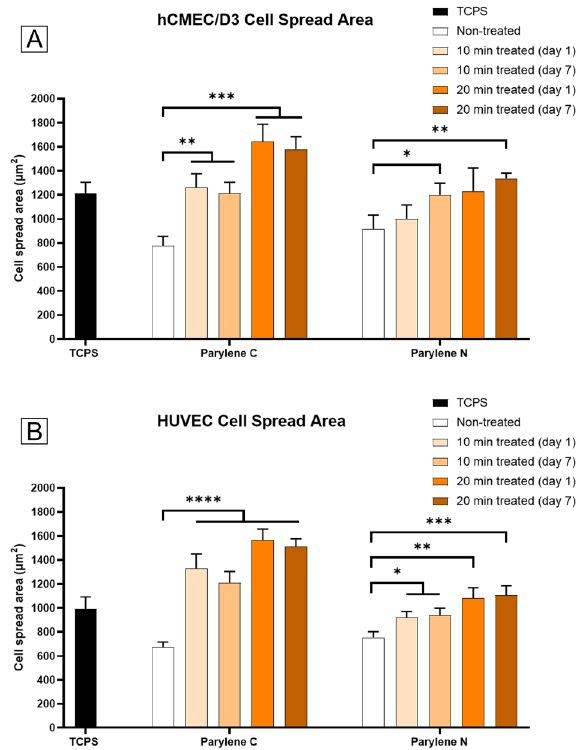
Figure 2. Changes in cell spread area of vascular endothelial cells on Parylene C and Parylene N membranes. ( A ) hCMEC/D3 cell spread area on TCPS, Parylene C, and Parylene N membranes. ( B ) HUVEC cell spread area on TCPS, Parylene C, and Parylene N